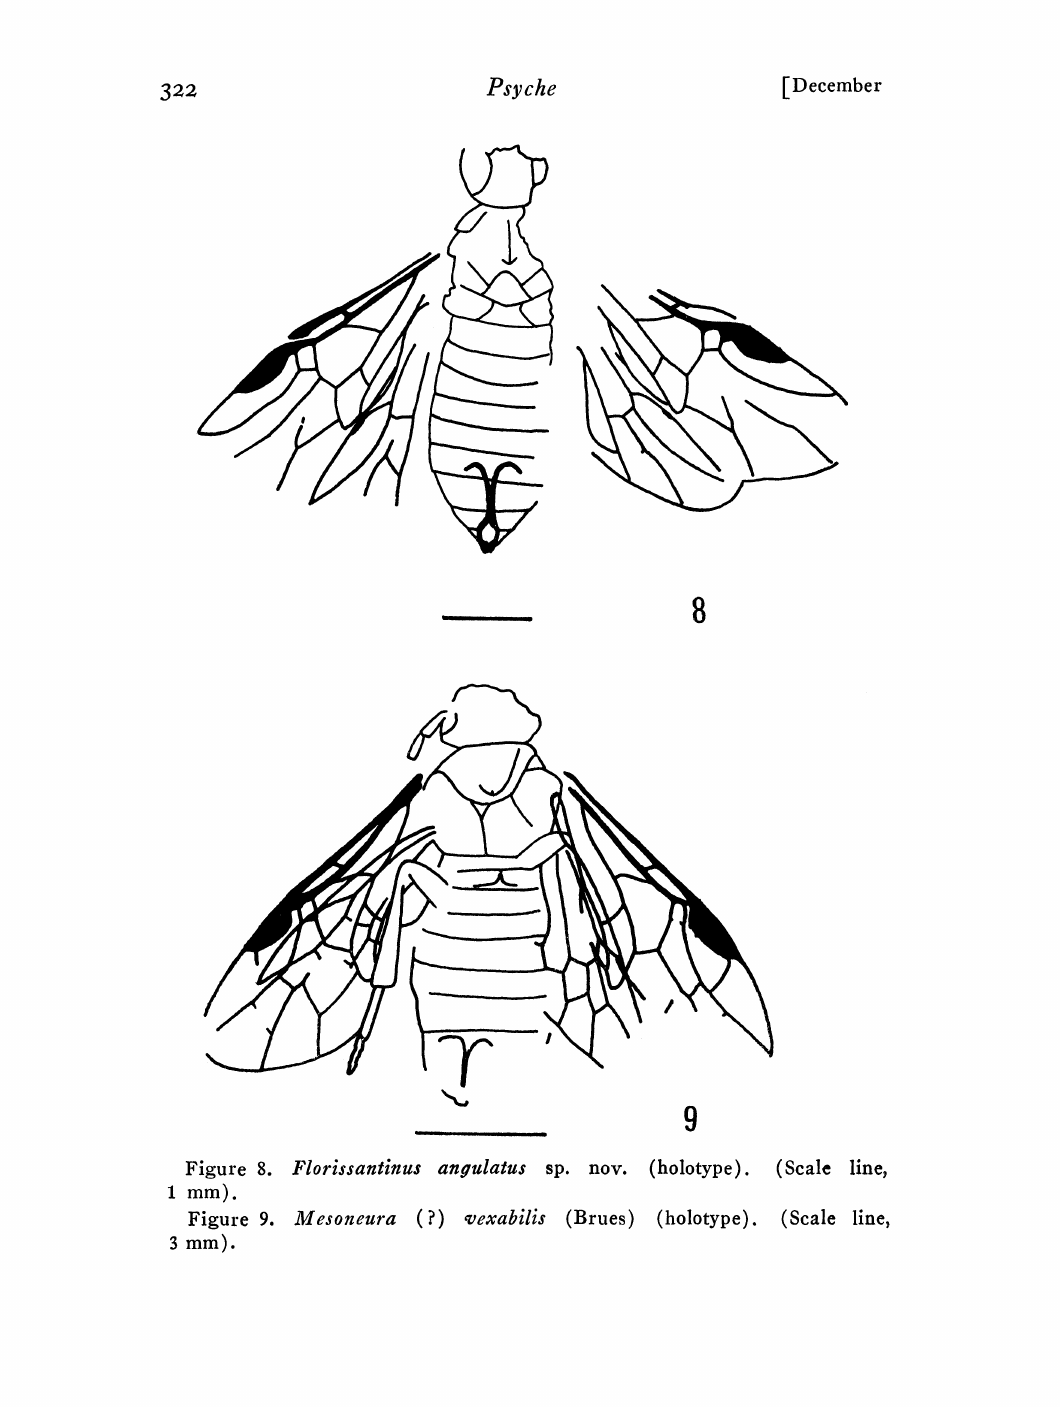
Figure 8. Florissantinus angulatus sp. nov. (holotype). (Scale line, 1 mm). Figure 9. Mesoneura (?) vexabilis (Brues) (holotype). (Scale line, 3